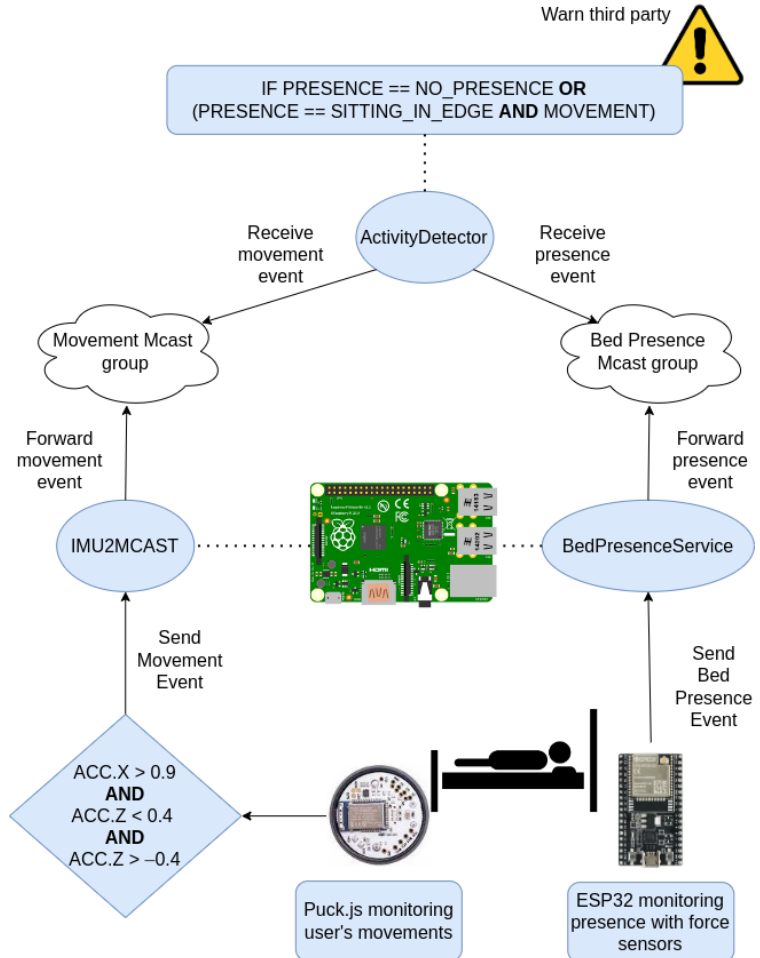
Figure 5. Overview of the fall-prevention